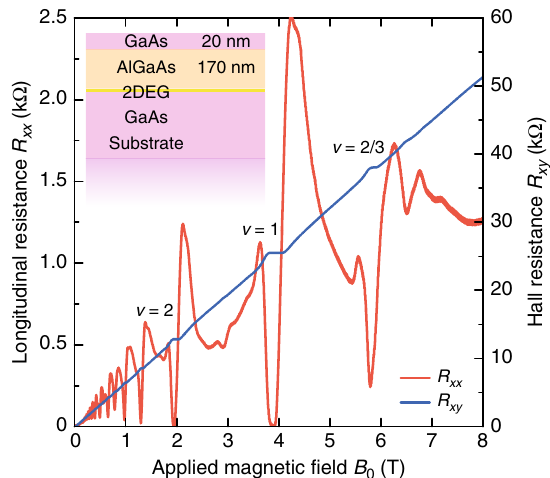
Fig. 5 Quantum Hall measurement of the GaAs/AlGaAs 2DEG sample at 0.3 K and zero gate voltage. The inset shows the out-of-plane structure of the sample